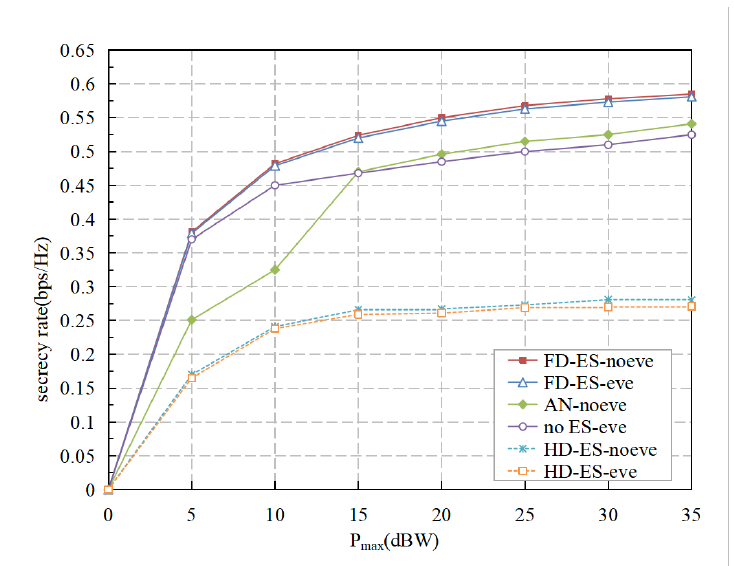
Figure 4. Secrecy rate vs. maximum available power at relay.